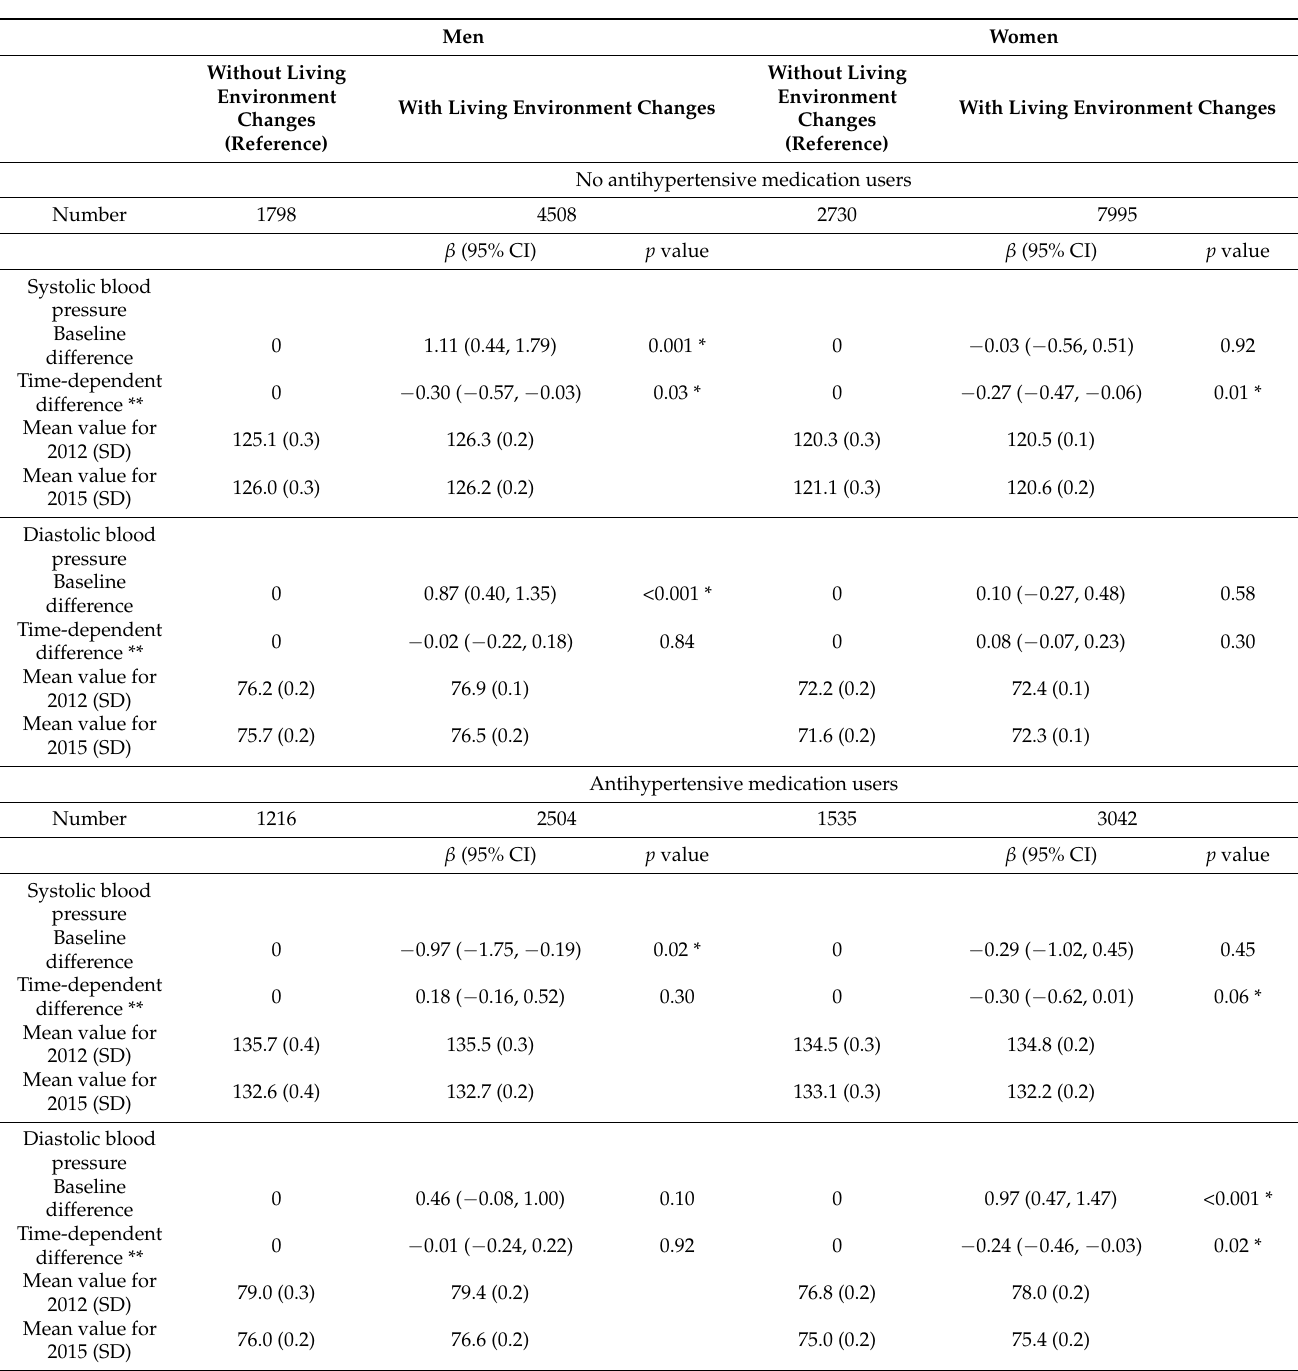
Table 3. Sex-specific changes in systolic and diastolic blood pressures with time by changes in living environment with and without antihypertensive medication